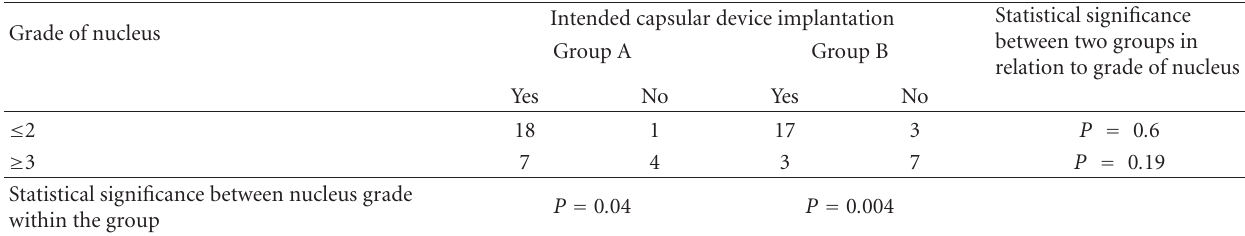
Table 4: Intended capsular device implantation according to the grade of nucleus in two groups.